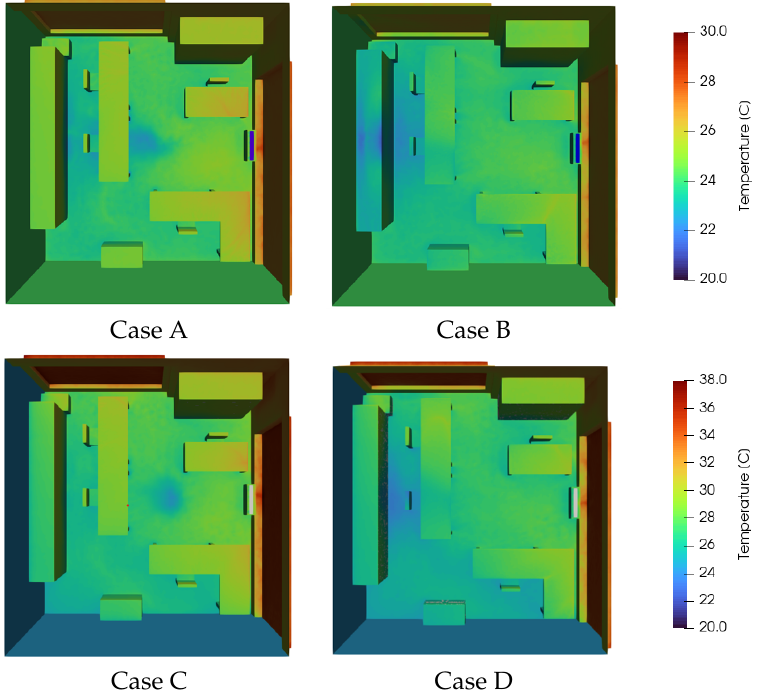
Figure 6. Top view of the internal temperature profile obtained in summer with low input air velocity and no solar load (Case A), high input air velocity and no solar load (Case B), low input air velocity and solar load (Case C), high input air velocity and solar load (Case D).